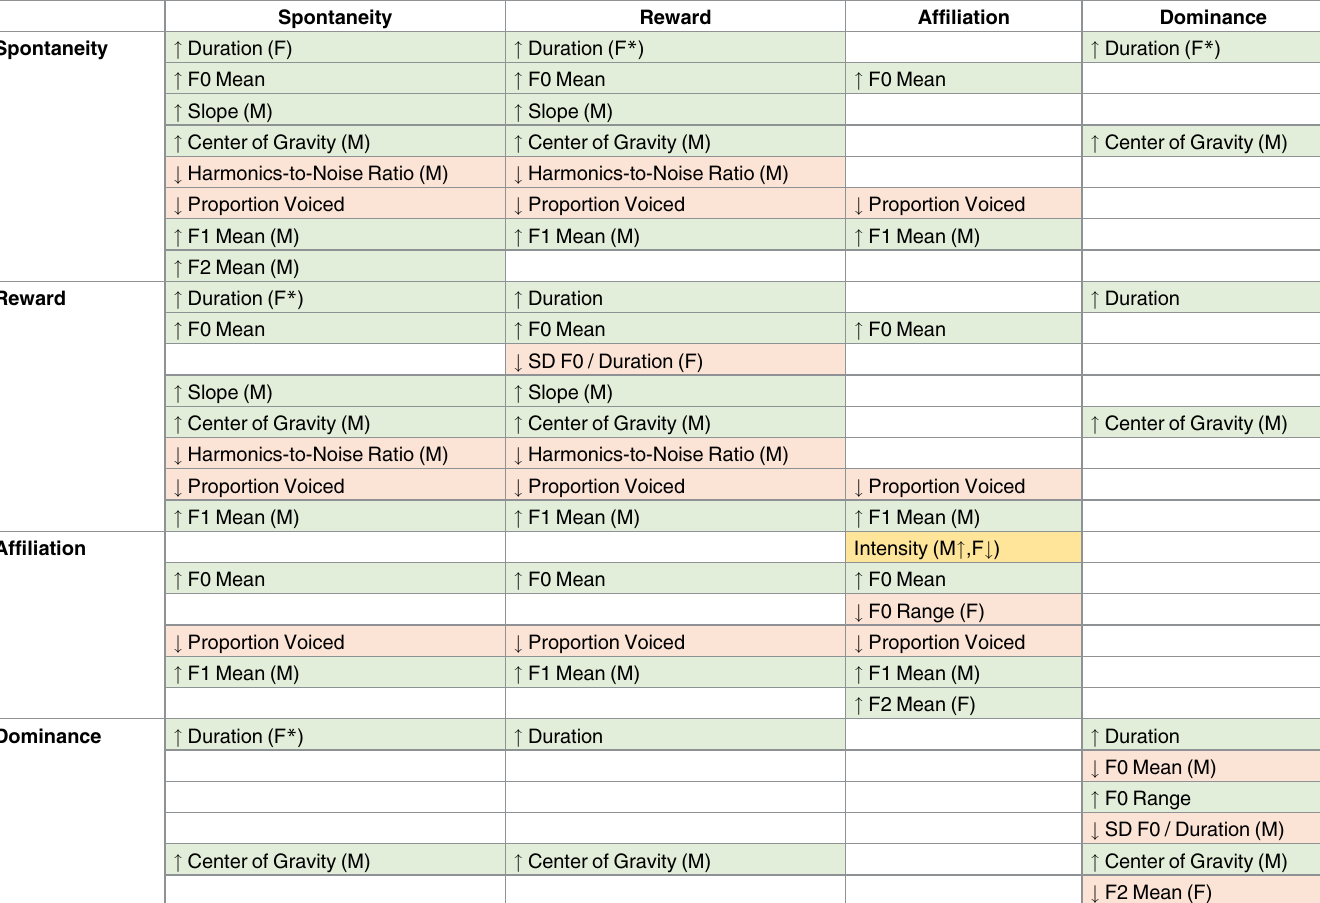
Table 5. Summaryof distinct and shared acoustic predictors of the four social judgments.